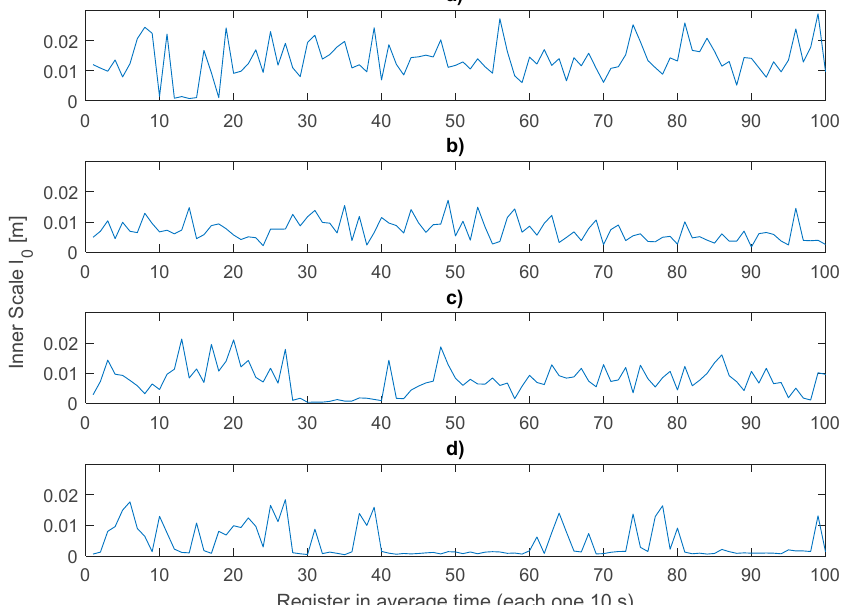
Figure 14. Scintillation index ( σ 2 ) according to Test: ( a ) Pattern. ( b ) Test #1. ( c ) Test #2. ( d ) Test #3. Source: Authors.